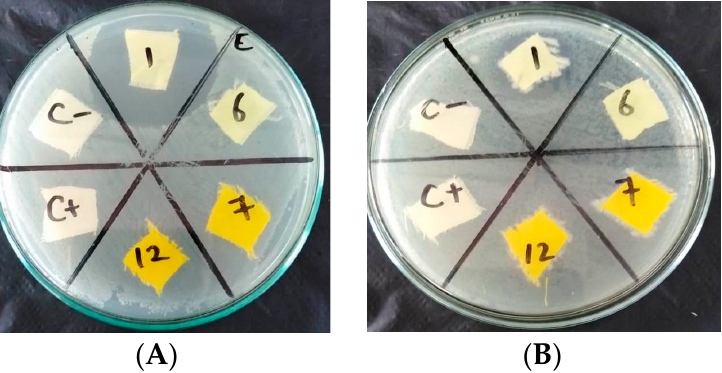
Figure 12. Escherichiacoli ( A ), Pseudomonasaeruginosa ( B ) treated with dyes 18h, 18i. Table 6. Antimicrobial activity of the dyed polyester fabrics with dyes 18h and 18i. Inhibition Zone Diameter (Nearest mm) Dye Also investigated was the antibacterial effectiveness of colored polyester fabrics against specific microbes. Untreated polyester fabrics against Bacillus subtilis , Staphylococcus aureus (Gram-positive), Escherichia coli , Klebsiella pneumoniae (Gram-negative), and Candida albicans (yeast) were used in the study under investigations. Table 7 clearly reveals that the colored polyester fabrics with dye disperse dyes 21a or 21b did not exhibit antibacterial action against all of the investigational microorganisms. Table 7. Antimicrobial activity of the dyed polyester fabrics with disperse dyes 21a and 21b .